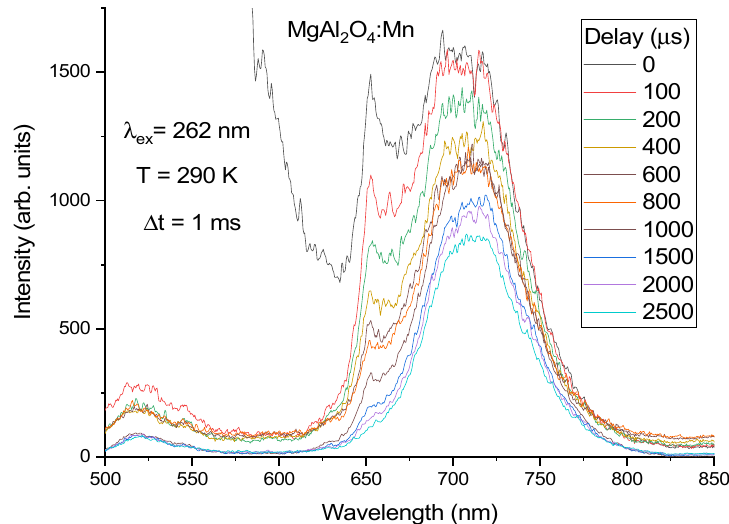
Figure 7. Time-resolved PL spectra of MgAl 2 O 4 :Mn (sample II) measured at 290 K at different delays (0 ÷ 2.5 ms) of the time gate ( ∆ t = 1 ms) with respect to the laser pulse.